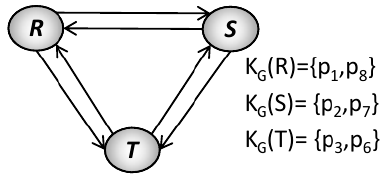
Figure 4. Pruning Graph of Figure 3.